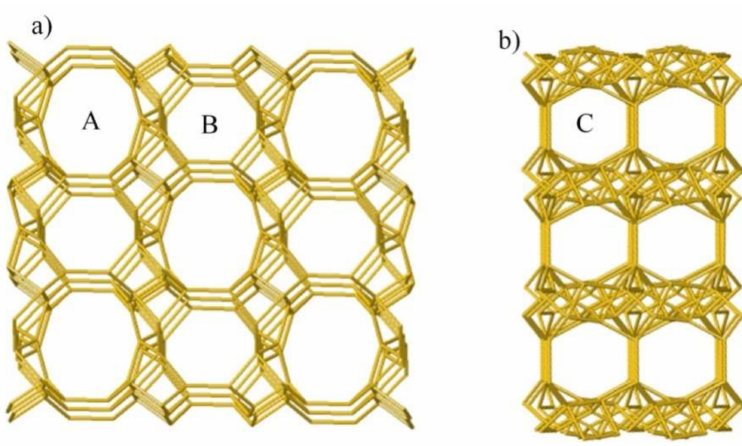
Figure 1. Three-dimensional structure of clinoptilolite, ( a ) [001] and ( b )